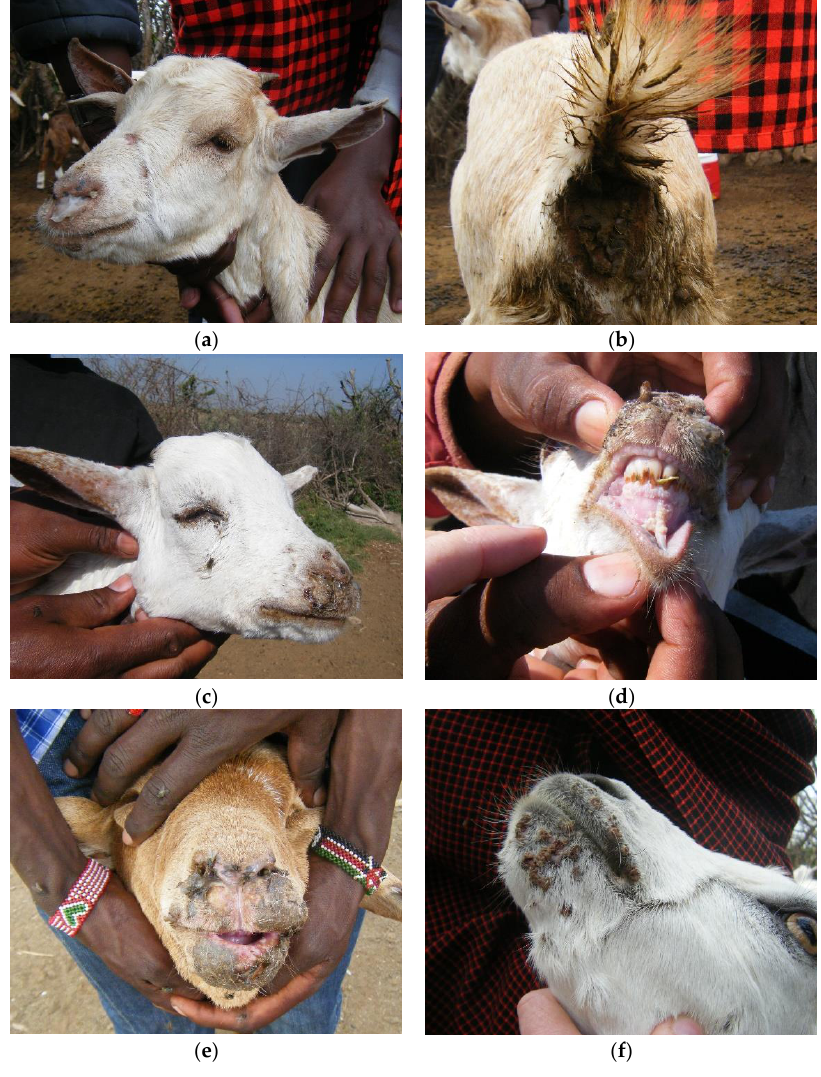
Figure 3. Clinical cases in Flock 1 (confirmed PPRV and bluetongue virus (BTV) infected) in Olorien-Magaiduru ward, showing a range of clinical signs: ( a ) 1–2-year-old goat with mucoid nasal discharge and ( b ) diarrhoea—peste des petits ruminants virus (PPRV) rapid diagnostic test (RDT) and PPRV real-time reverse transcription polymerase chain reaction (RT-qPCR) positive; ( c ) 2–3-month-old goat with lacrimation, nasal discharge, peri-oral skin lesions and ( d ) mouth lesions—not tested; ( e ) 8-month-old sheep with nasal discharge, swollen and ulcerated muzzle and ulceration inside lips and tongue—PPRV-RDT and PPRV RT-qPCR negative; ( f ) 1-year-old goat with peri-oral skin lesions—not tested.